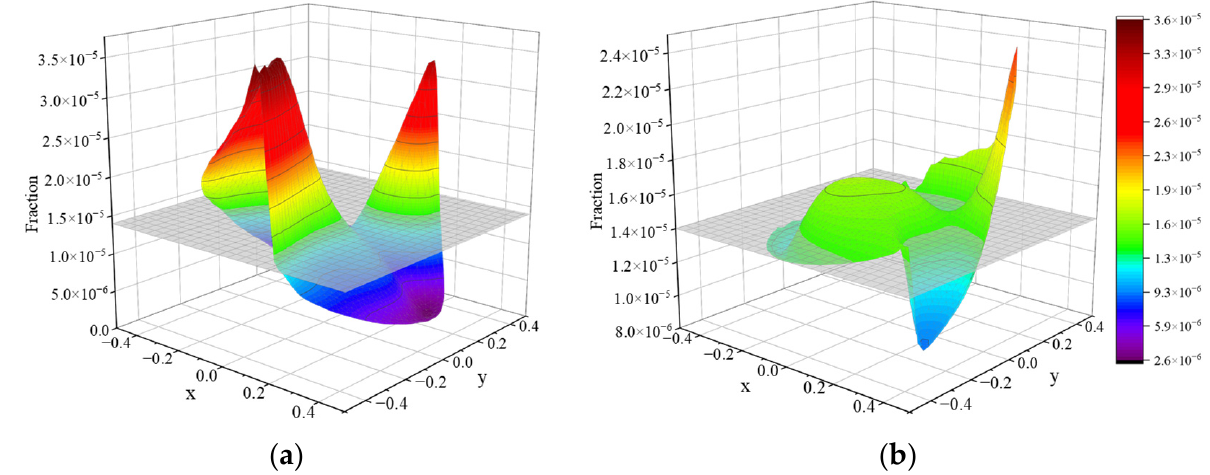
Figure 6. Comparison of flocculant export quality fraction before and after optimization: ( a ) before optimization; ( b ) after optimization.